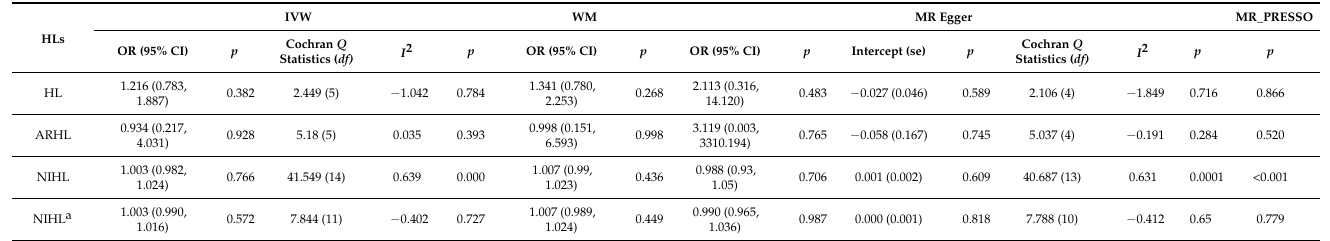
Table 2. Mendelian randomization estimates for the association between TL and HL and its